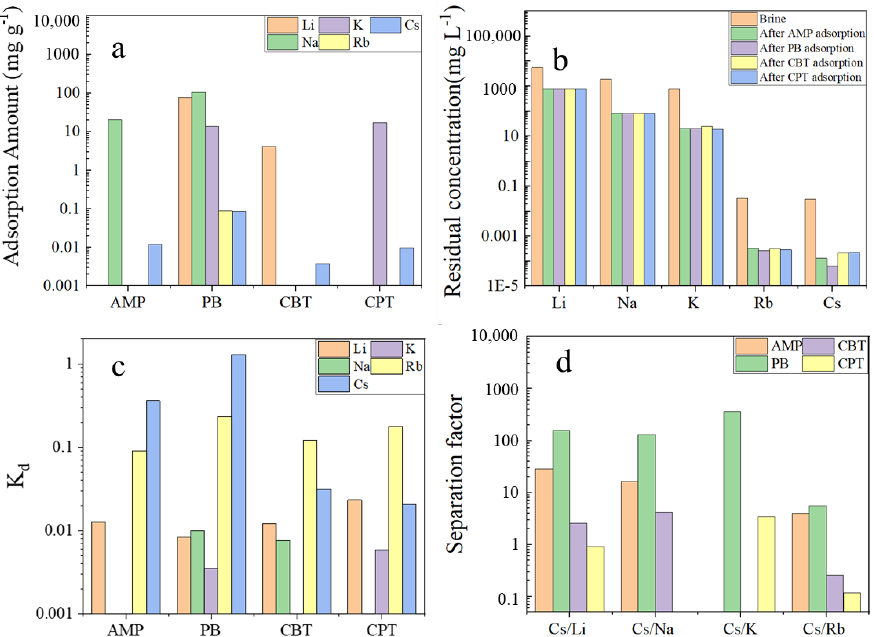
Figure 6. ( a ). Adsorption amount of adsorbents in brine ( b ). Residual concentration of ions in the solution after adsorption ( c ). Distribution coefficient of ions ( d ). Separation factor of cesium to other ions.